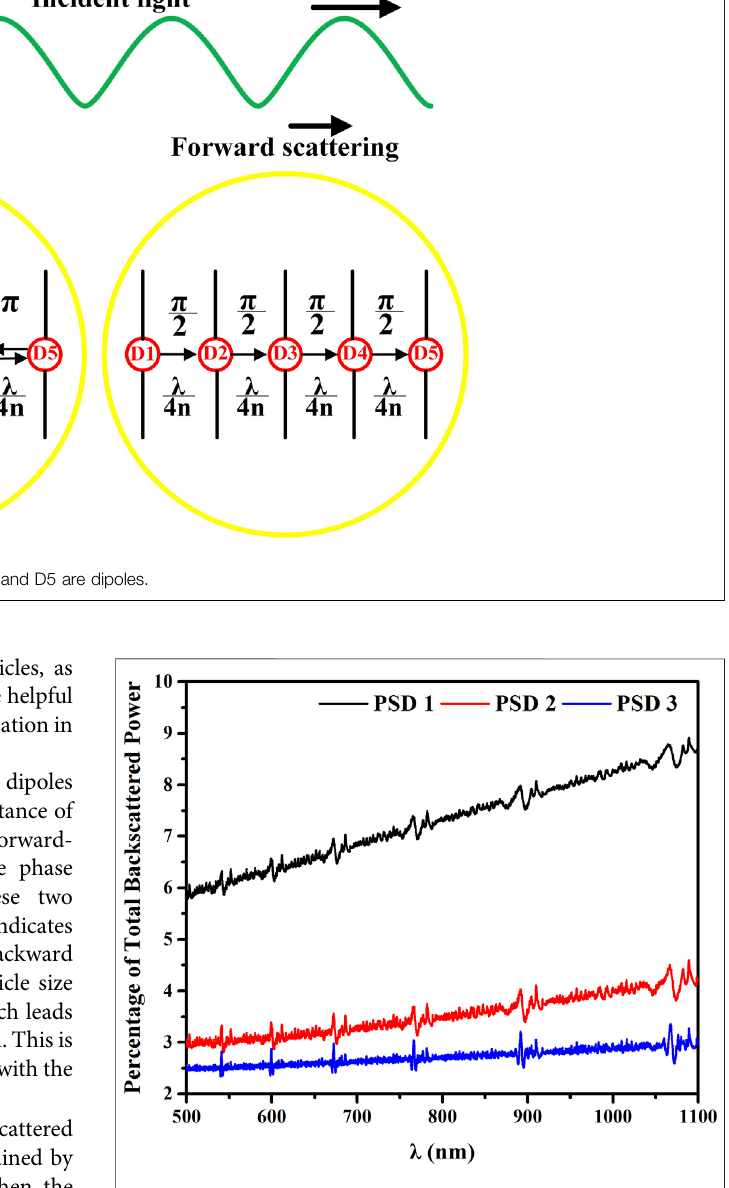
FIGURE5| Percentageoftotalbackscatteredpowerofdifferentparticle size